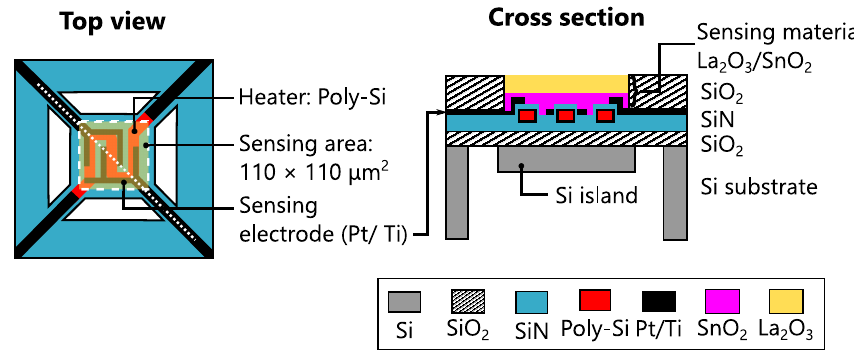
Figure 1. Schematic illustration of the device. The left and right figures represent its top and cross-sectional views, respectively. The location of the cross section is indicated as a white dotted line in the top view. Note that the upper SiO 2 layer is not shown in the top view for the ease of